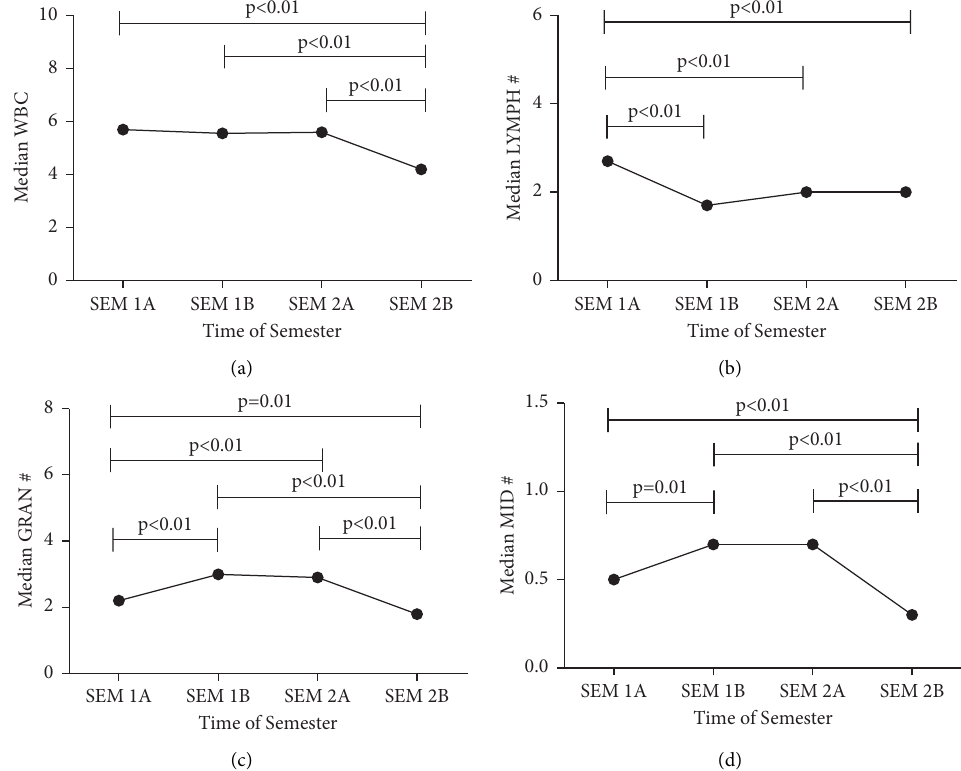
Figure 2: The trend of the white blood cell differentials during one academic year. (a) The trend of total WBC count. (b) The trend of the change in absolute lymphocyte count. (c) The pattern of the change in absolute granulocyte count of participants. (d) The pattern of the change in the absolute MID count of participants. Statistical comparisons were undertaken using Kruskal–Wallis with Dunn’s multiple comparison test (Semester 1A, early part of first semester; Semester 1B, latter part of first semester; Semester 2A, early part of first semester; Semester 2B, latter part of second semester; WBC, white blood cell; #, absolute; MID: a collective term for monocytes, basophil, and eosinophil